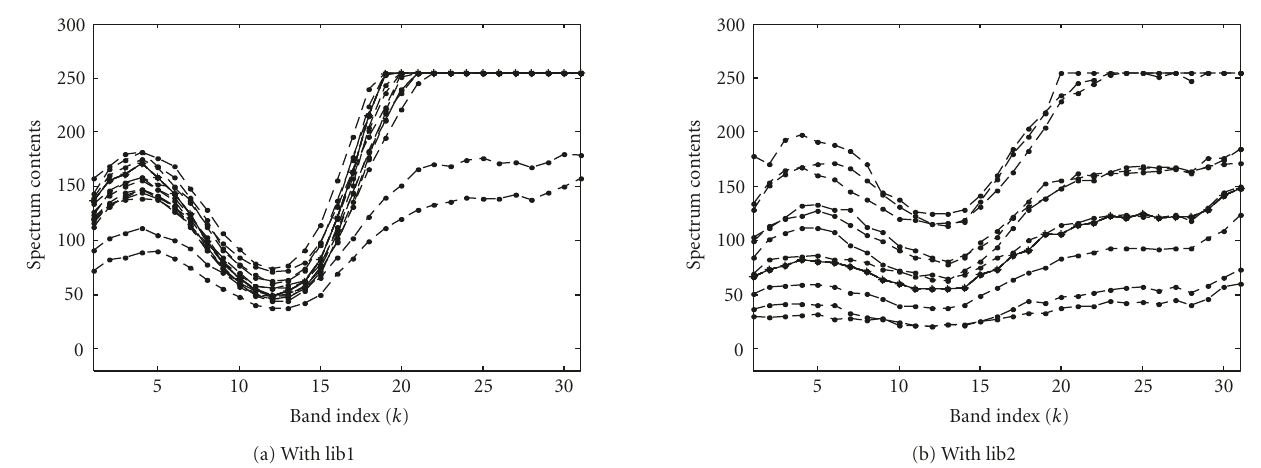
Figure 19: The refined libraries of lib1 and lib2 ( A t = 0 . 9).